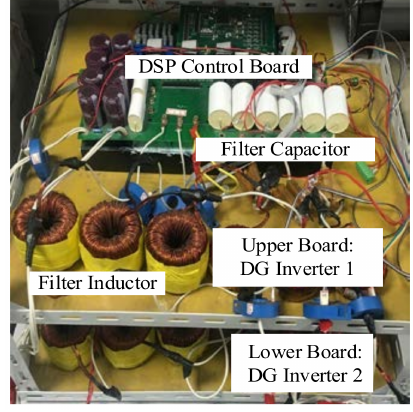
Figure 7. Test-rig setup in the